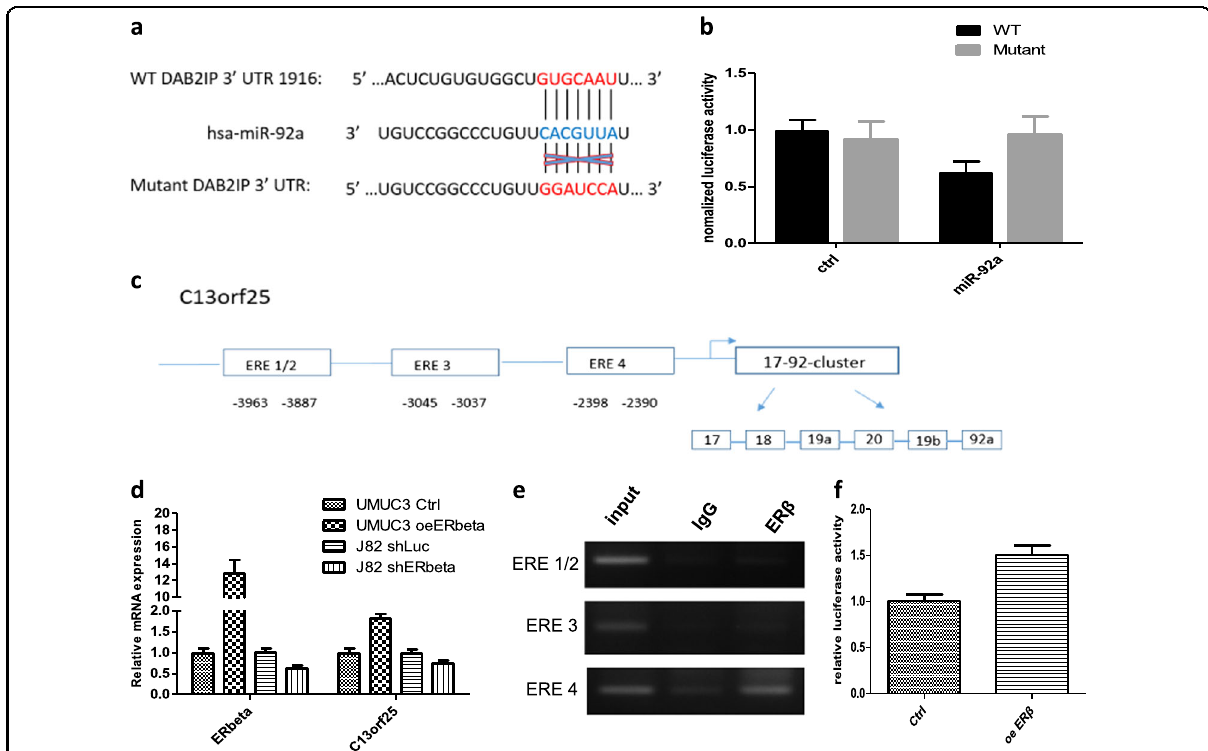
Fig. 4 Mechanism dissection of how miR-92a inhibits DAB2IP expression and how ER β transcriptionally up-regulates miR-92a expression. a DAB2IP 3 ′ UTR containing wild-type (WT) or mutant miRNA-binding sites were cloned into the psiCheck2 vector. b We co-transfected miR-92a and psiCheck2-DAB2IP 3 ′ UTR constructs containing WT or mutant miR92a-targeted binding regions into 293 T cells, and the luciferase activity was assayed. c Schematic depiction of the potential ER β -binding sites on the 5 ′ promoter region of the C13orf25 gene that could produce the miR-92a. d Expression of C13orf25 in UMUC3 cells with/without oeER β and J82 cells with/without shER β were detected by real-time qPCR. e The ChIP assay showed that ER β could bind to the 4 th predicted ERE site in the promoter of the miR-92a host gene. f UMUC3 cells were transfected with a 2.4